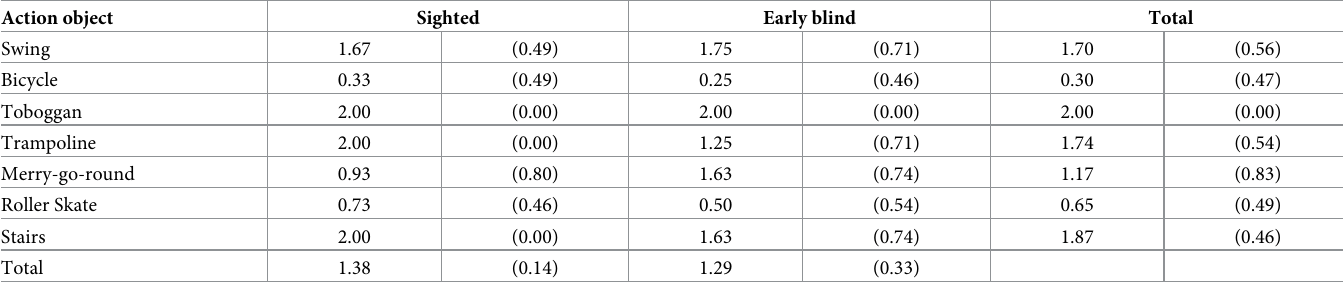
Table 2. Identification scores (max 2.00) and (SD) in sighted (N = 15) and early blind children (N = 8) for each action object explored with the ASFG